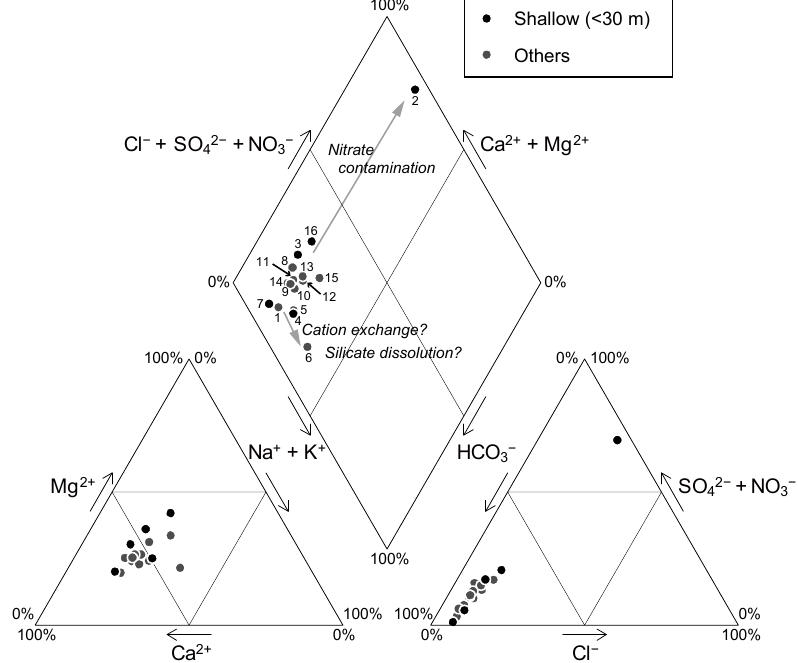
Figure 7. Chemical compositions of groundwater shown in a Piper